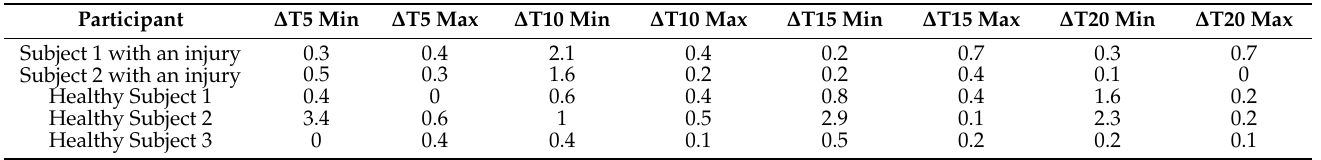
Figure 6. Thermogram from the back of the hand of one of the participants at moments 5 ′ , 10 ′ , 15 ′ , and 20 ′ . Table 4 shows the minimum and maximum temperature differences of the palmar and dorsal areas between the right and left wrists calculated for each period. Table 4. Values of the minimum and maximum temperature differences from the back of the hand obtained from the participants by time.